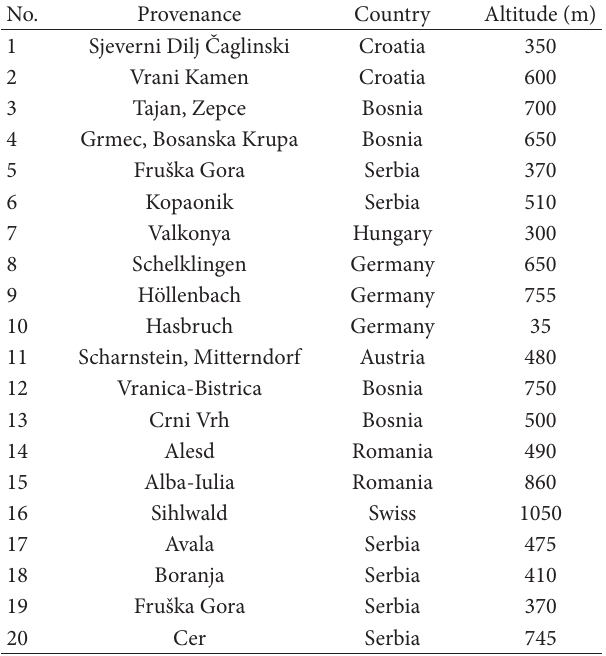
T 1: Investigated beach provenances, country of origin, and appropriate